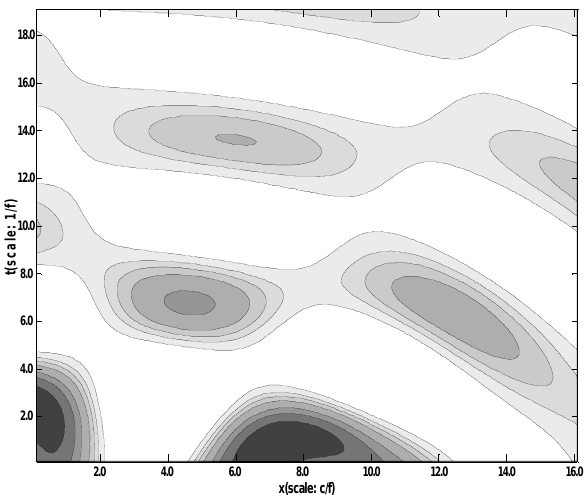
Figure 2. To illustrate the effect of the superposition of forcings at different places and Fig. 2. To illustrate the effect of the superposition of forcings at times as indicated by (3.9), the figure shows the spatio-temporal structure of the different places and times as indicated by Eq. (20), the figure shows superposition of the responses to two pulsations of forcing at ( x, t ) = (0, 0) and ( x, t ) = the spatio-temporal structure of the superposition of the responses (10, -2) (contour lines in divergent regions are not shown). A more complex structure to two pulsations of forcing at ( x,t) = ( 0 , 0) and ( x,t) = ( 10 , − 2) can be found due to this superposition. (contour lines in divergent regions are not shown). A more complex structure can be found due to this